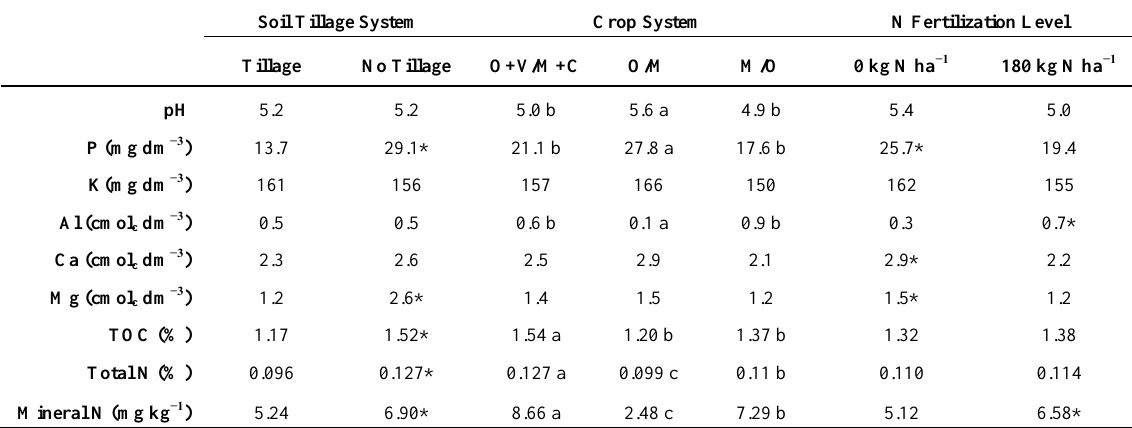
Table 2. Soil features measured on samples from the different treatments. Asterisk indicates significant difference between the correspondent treatments on the line, by qui- square test. Numbers followed by the same letter are not statistically different by Tukey test under p -value ≤